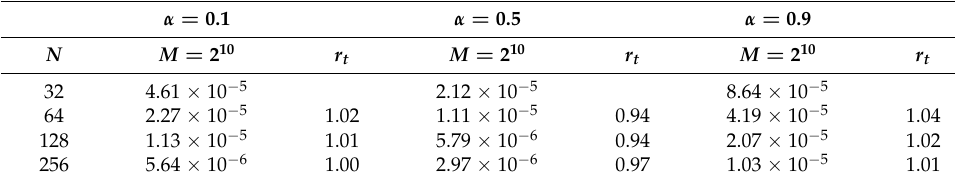
Table 1. Temporal convergence orders under different α .